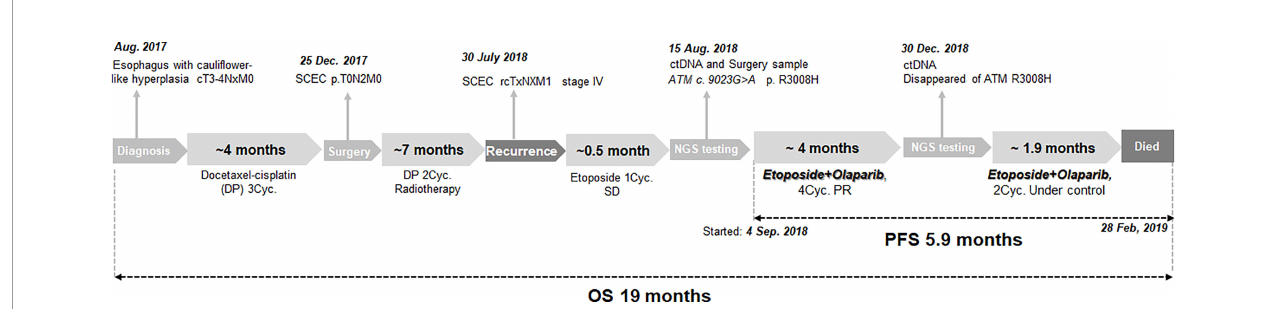
FIGURE 1 | The fl owchart of the case timeline to illustrate the diagnosis and